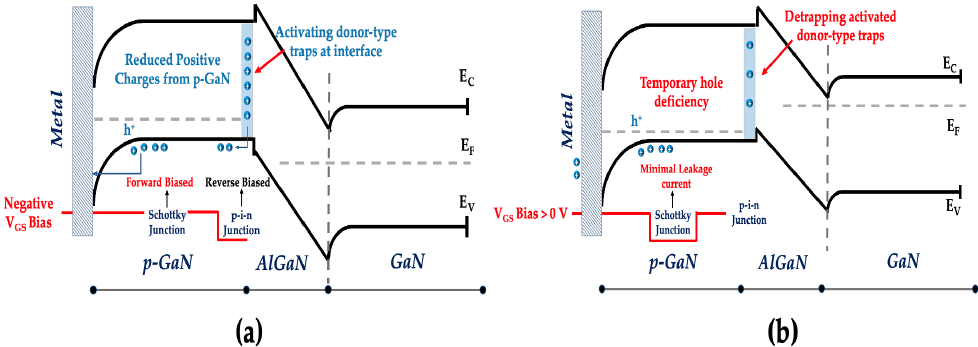
Figure 9. Band diagram of the p-GaN gate HEMT ( a ) device under negative gate bias stress condition and the ( b ) device after stress condition under turn-on